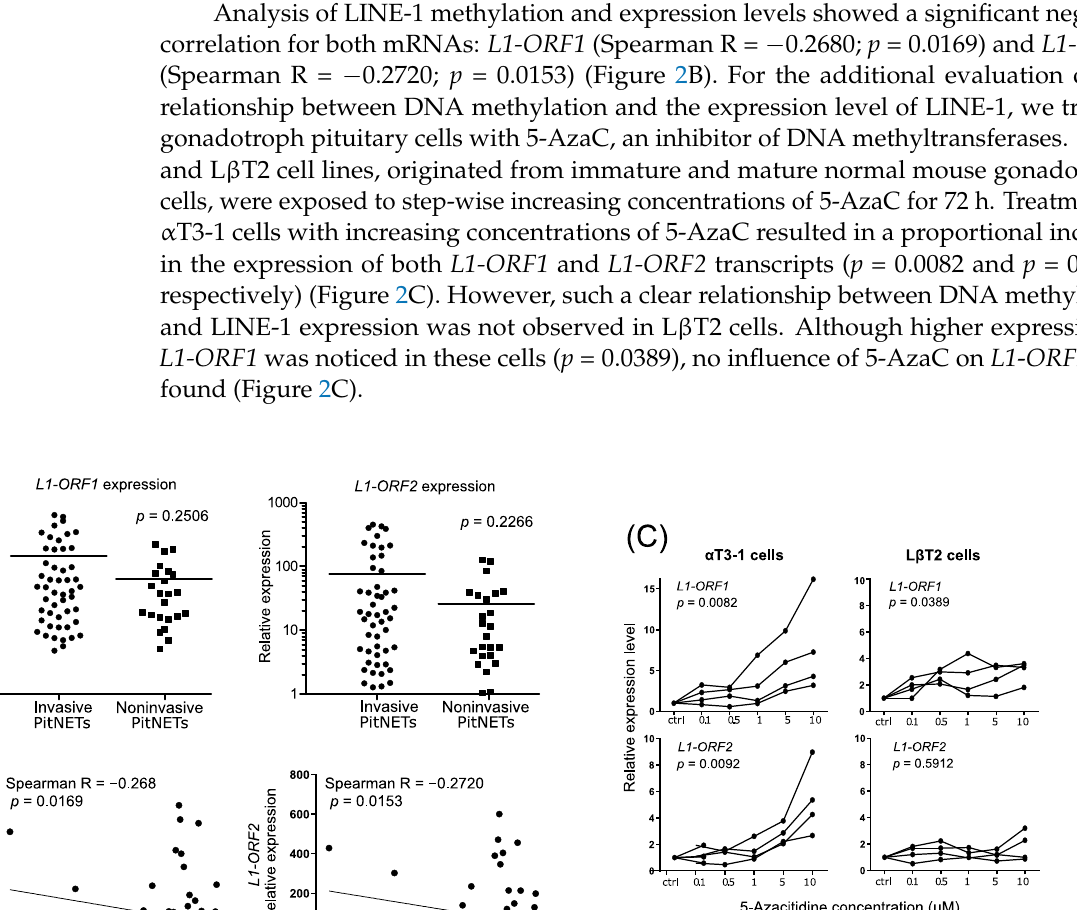
Figure 1. LINE-1 DNA methylation in nonfunctioning gonadotroph PitNETs. ( A ) Comparison of invasive ( n = 54) and noninvasive ( n = 26) tumors. Each dot represents average LINE-1 methylation level in the sample. Horizontal lines indicate mean values; ( B ) ROC (receiver operating characteristic) curve analysis for LINE-1 DNA methylation as classifier of inva- sive growth status; ( C ) Correlation between LINE-1 methylation and genome-wide methylation levels estimated as me- dian β -value from HM450K arrays. Each dot represents PitNET sample ( n = 18).